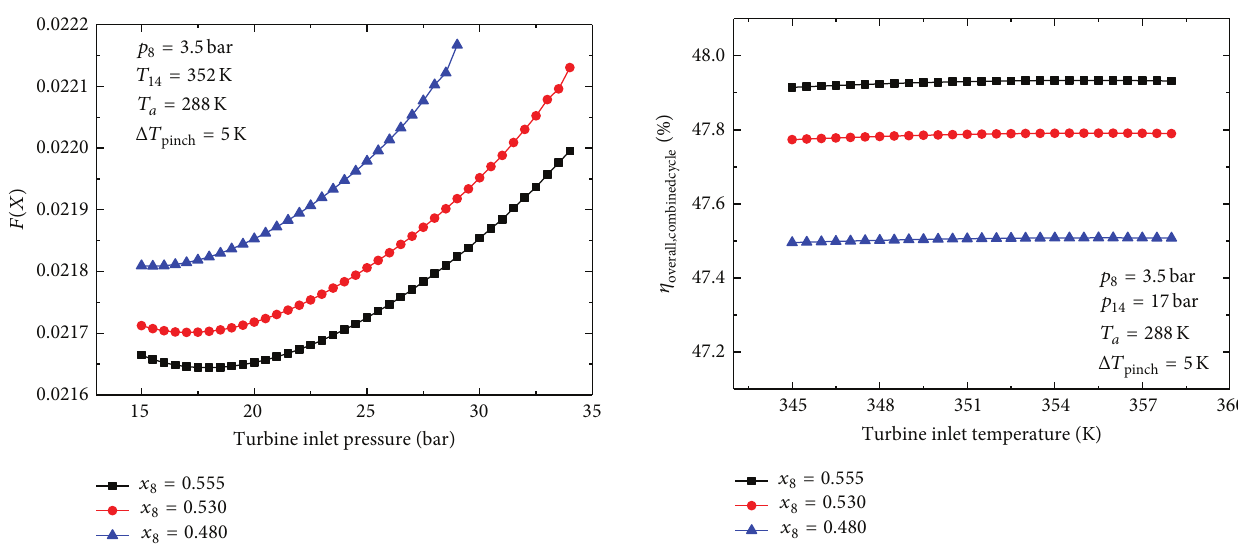
Figure 9: Variation of 𝐹(𝑋) of combined cycle with turbine inlet pressure.